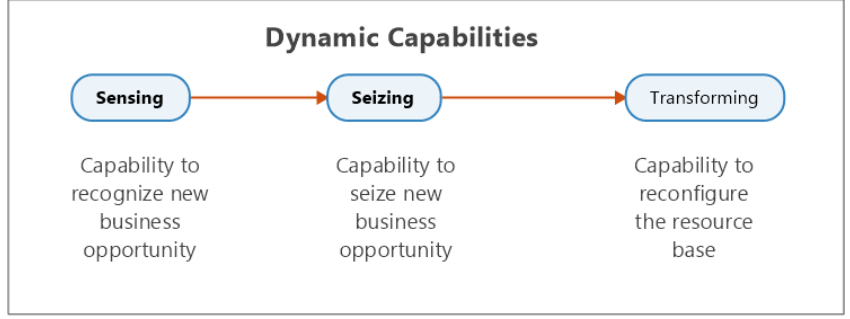
Figure 1. The structure of dynamic capabilities.